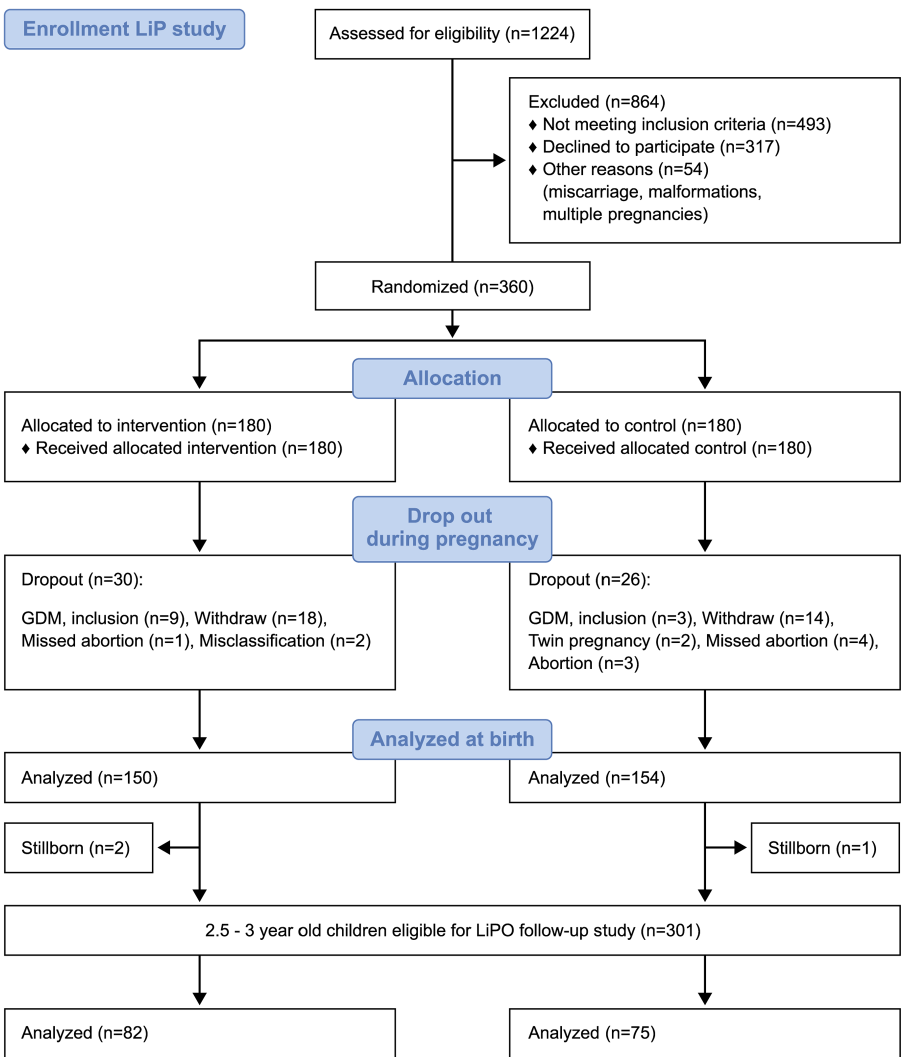
Figure 1. Participation rates in the LiP and LiPO studies. Legend: GDM = gestational diabetes mellitus. LiP = Lifestyle in Pregnancy. LiPO = Lifestyle in Pregnancy and Offspring.